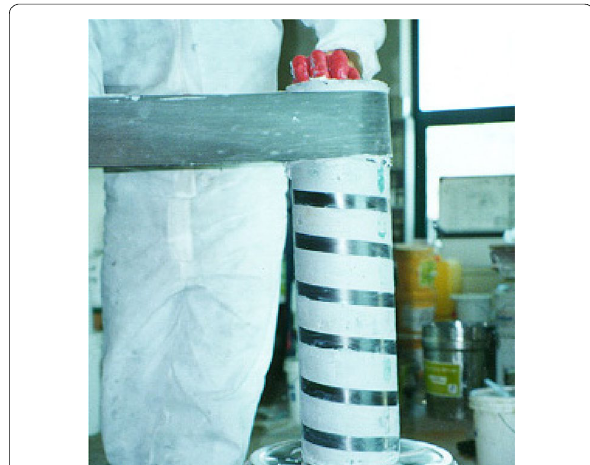
Fig. 9 Retrofitting process on H2‑I1 specimen.